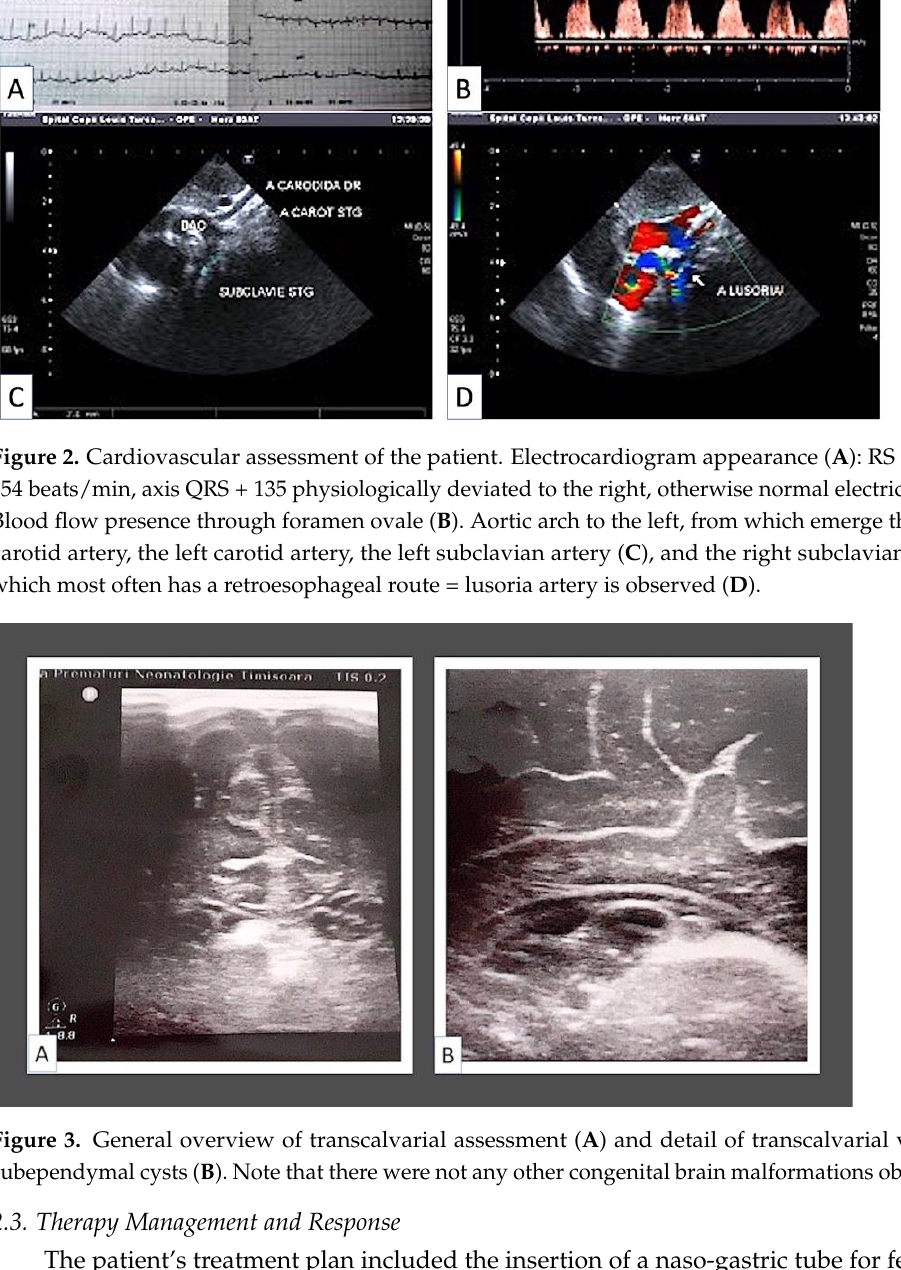
Figure 3. General overview of transcalvarial assessment ( A ) and detail of transcalvarial view of sub- ependymal cysts ( B ). Note that there were not any other congenital brain malformations observed.